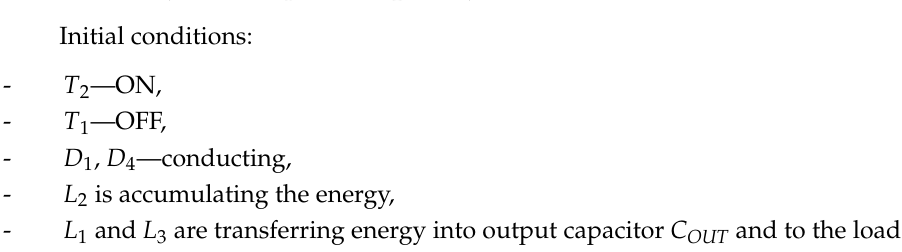
Figure 7. Equivalent circuit of proposed converter operation during 2nd interval.